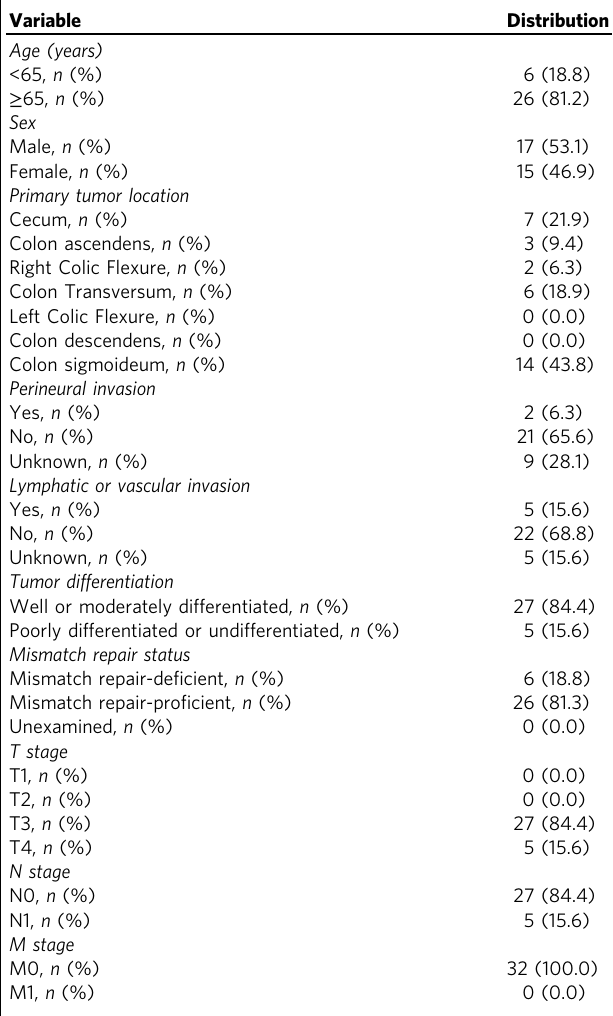
Table 1 Clinicopathological characteristics of the patient